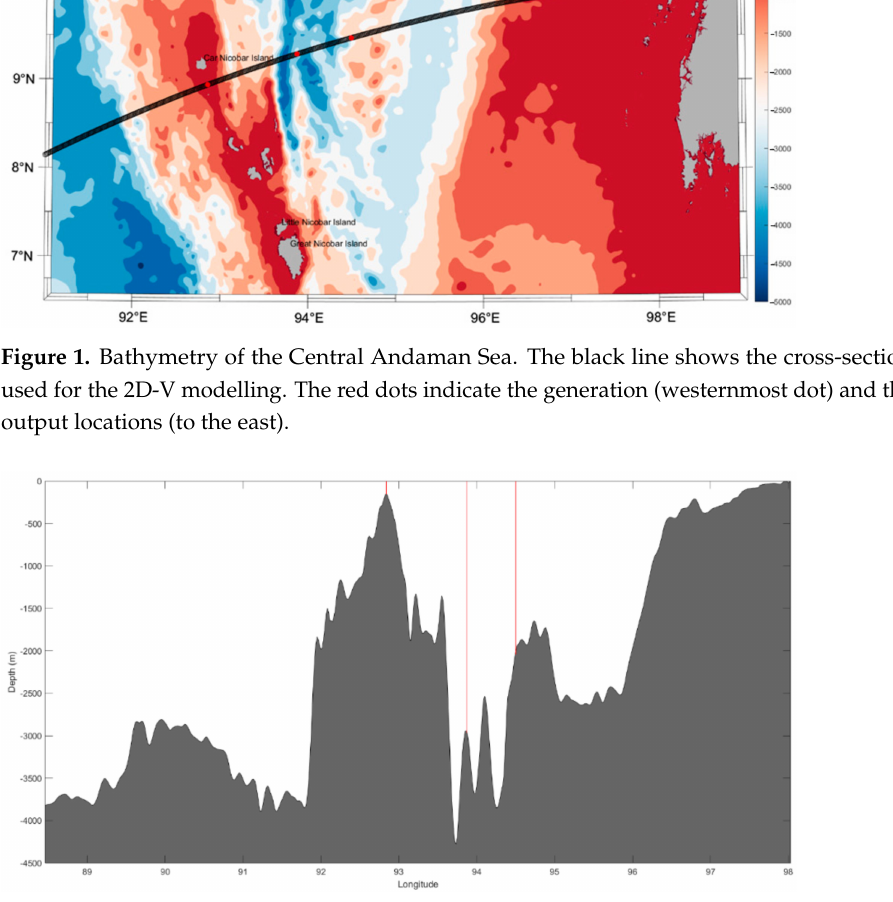
Figure 2. Bathymetry of the cross-section shown in Figure 1. The vertical red lines show the generation location at approximately 93 ◦ E and the output locations approximately 100 km and 140 km to the